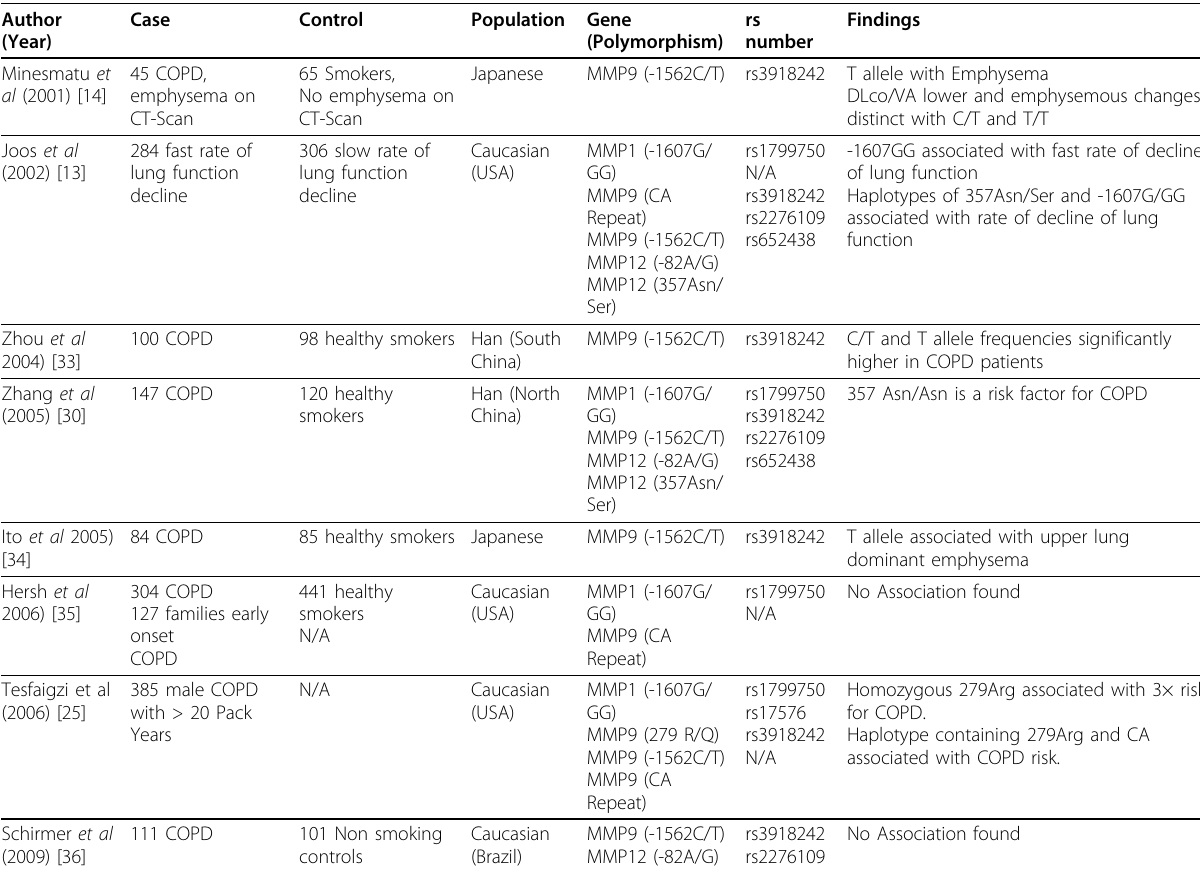
Table 1 Previous association studies performed in COPD